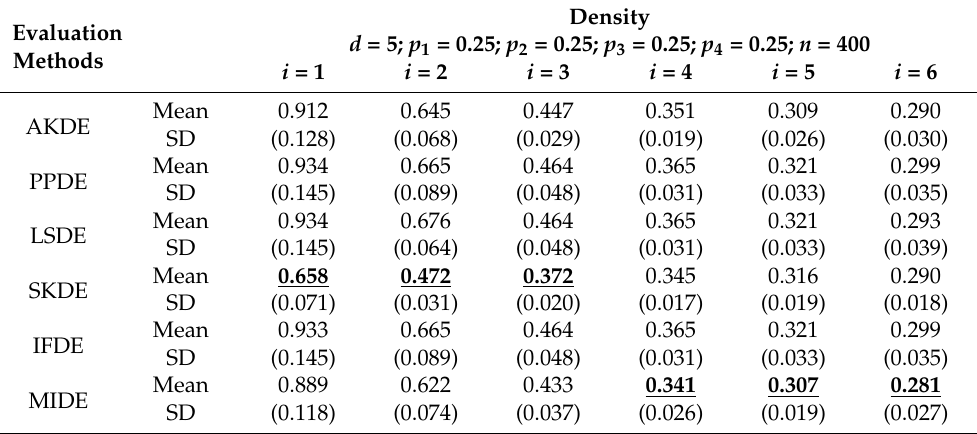
Table A5. 10 4 times upscaled mean absolute error with d = 5; p 1 = 0.25; p 2 = 0.25; p 3 = 0.25; p 4 = 0.25; n = 400.